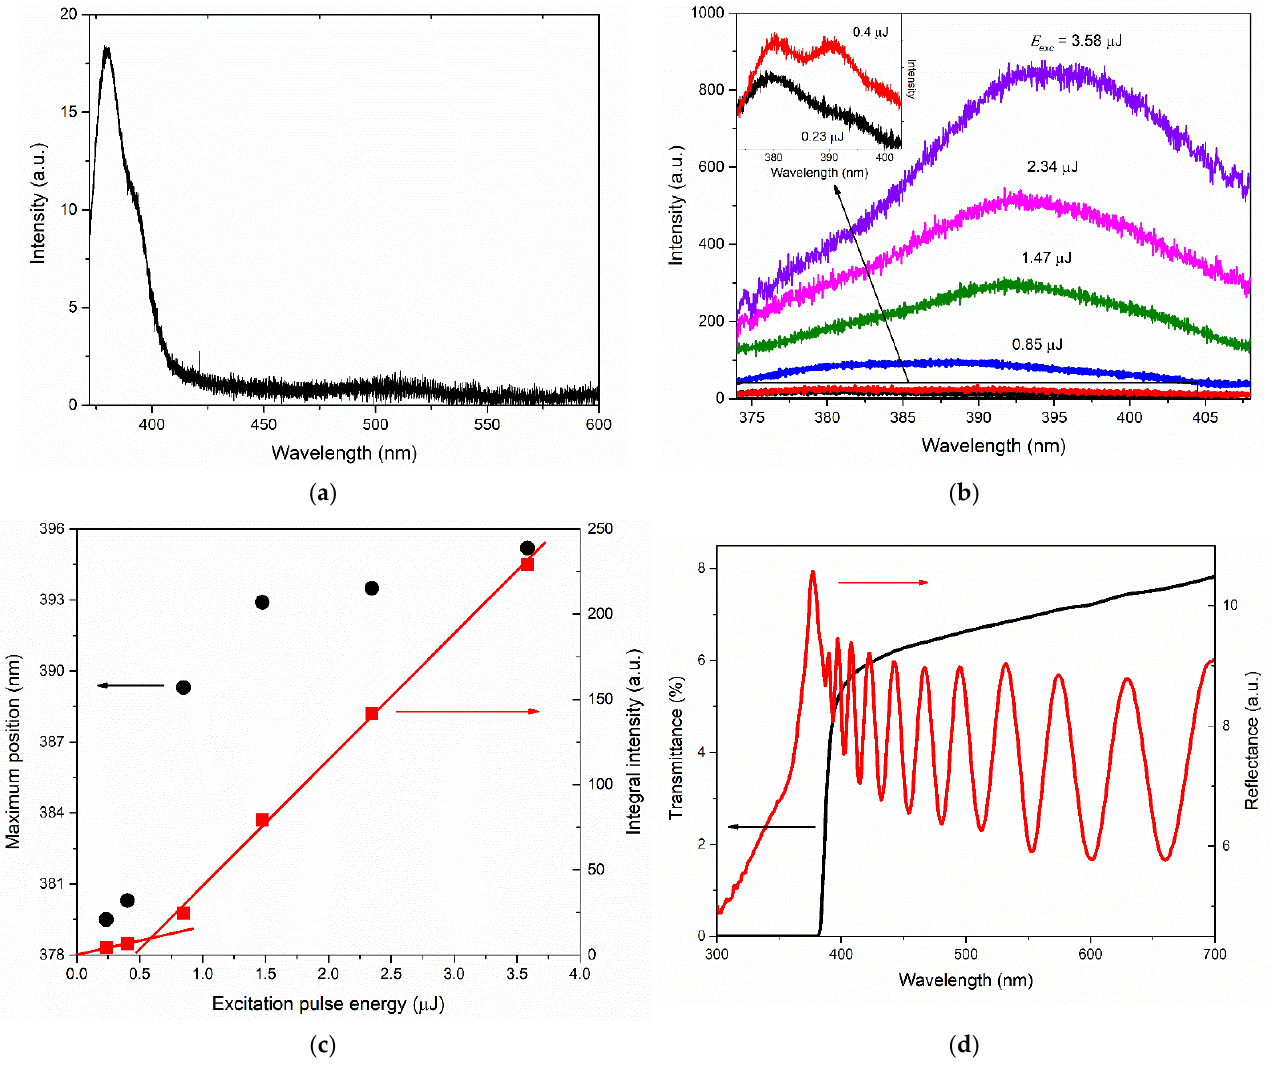
Figure 6. Optical and emission properties for the type-M film: ( a ) PL spectra recorded at E exc ≈ 0.25 µJ; ( b ) NBE emission spectra at different E exc ; ( c ) dependence of NBE emission integral intensity (red squares) and maximum position (black circles) on E exc ; ( d ) transmittance (black) and directional reflectance (red) spectra.